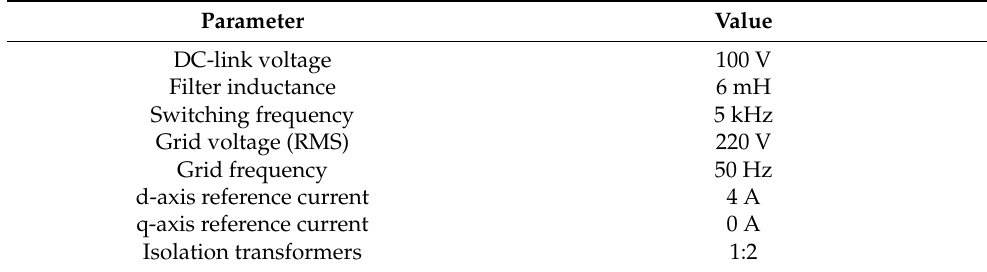
Figure 7. Three-phase grid-connected inverter experimental platform. Table 2. System